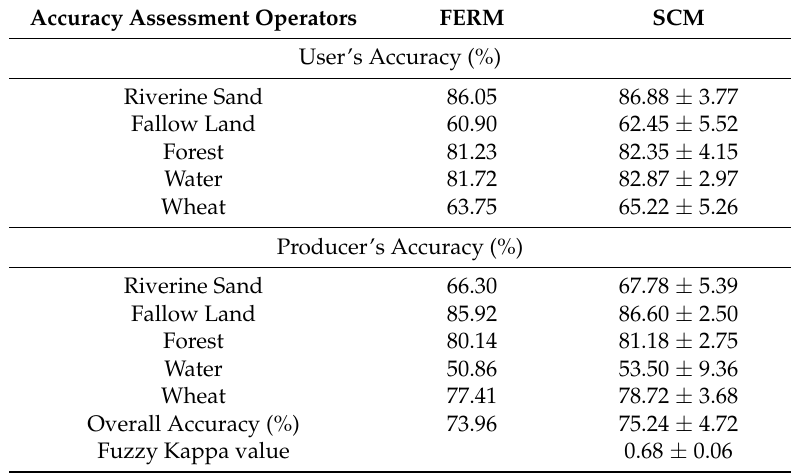
Table 8. Details of accuracy assessment for classification results of Landsat-8 data using a single measure.